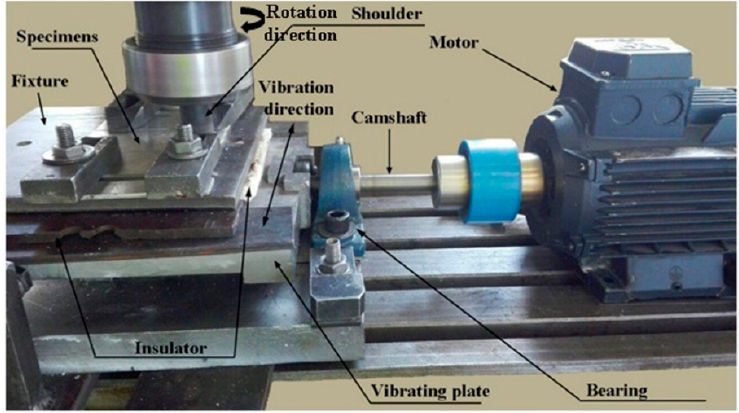
Figure 1. The machine designed and manufactured for FSVW process.